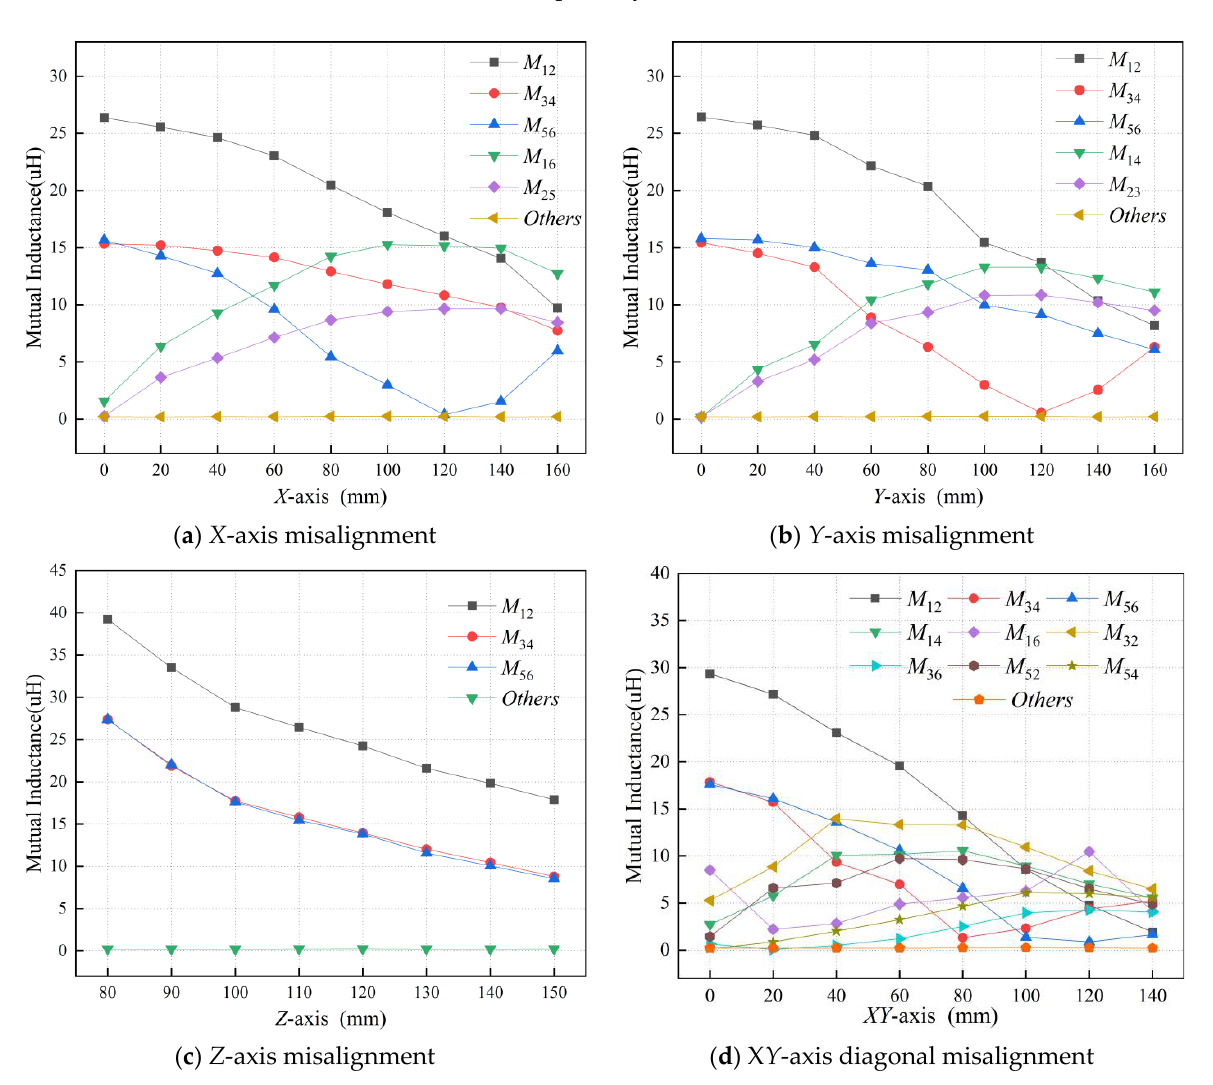
Figure 8. Measured mutual inductances of DD2Q coils.